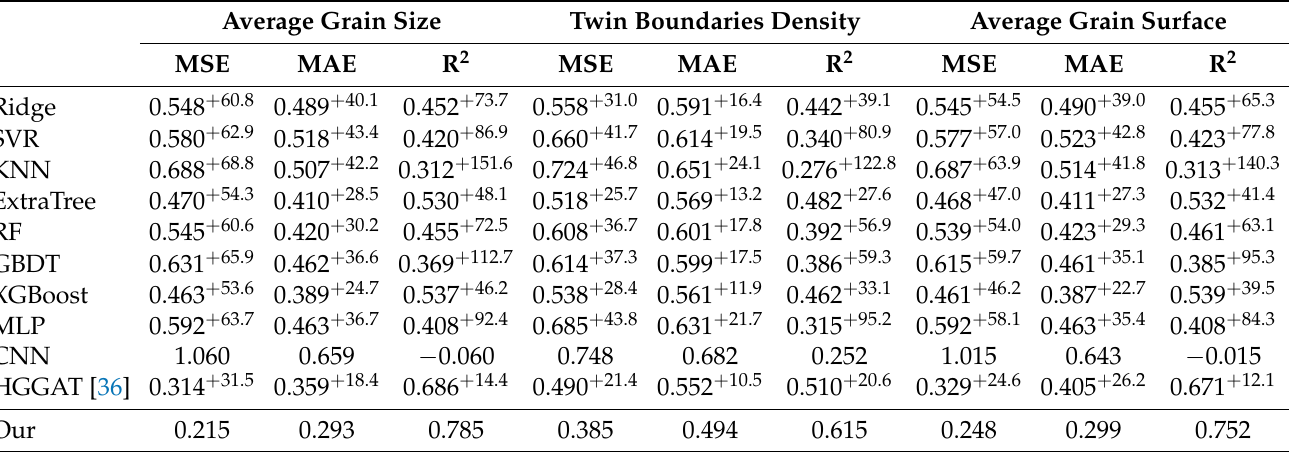
Table 2. The results of the models are compared in terms of average grain size, twin boundaries density and average grain